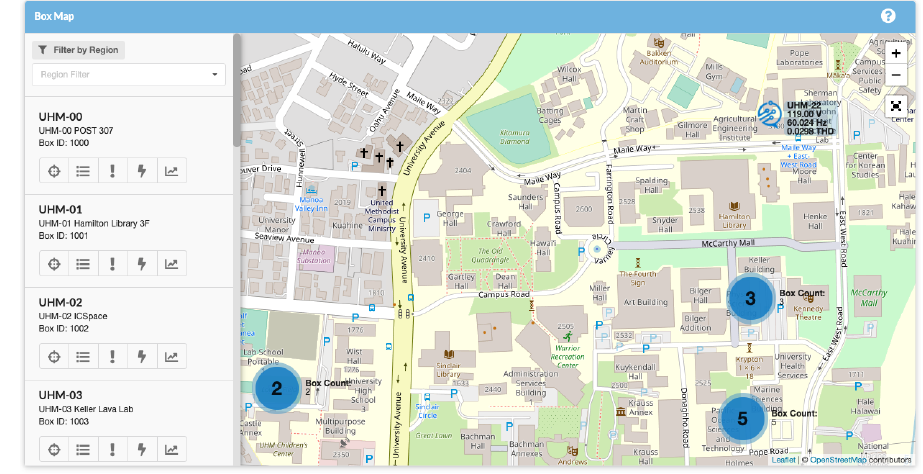
Figure 7. OPQ View: Box